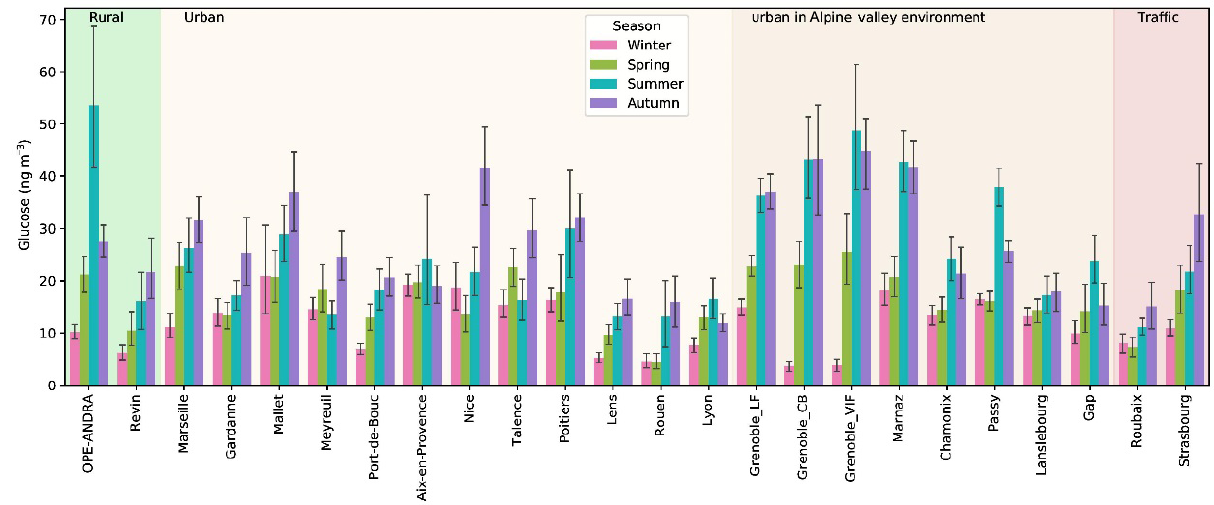
Figure 7. Spatial and seasonal distributions of atmospheric glucose levels (ngm − 3 ) for various types of sites in France (except the site of Nogent, which presented too many missing values). Error bars correspond to standard deviations calculated with seasonal concentrations.